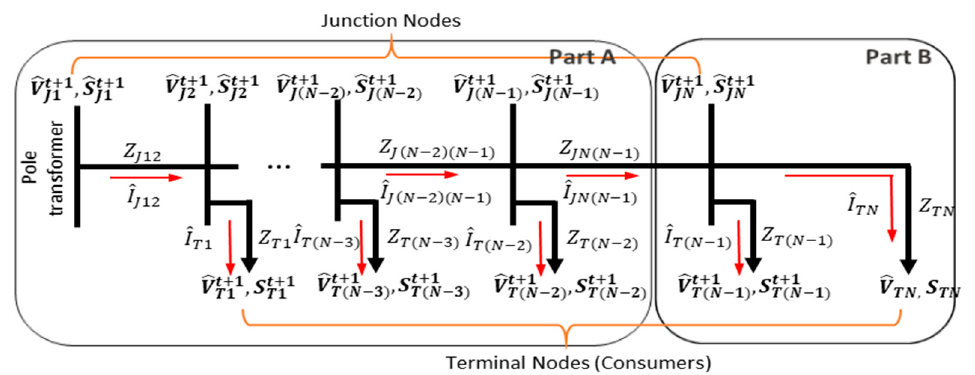
Figure 9. Generalized Linear Low-Voltage Distribution network topology.